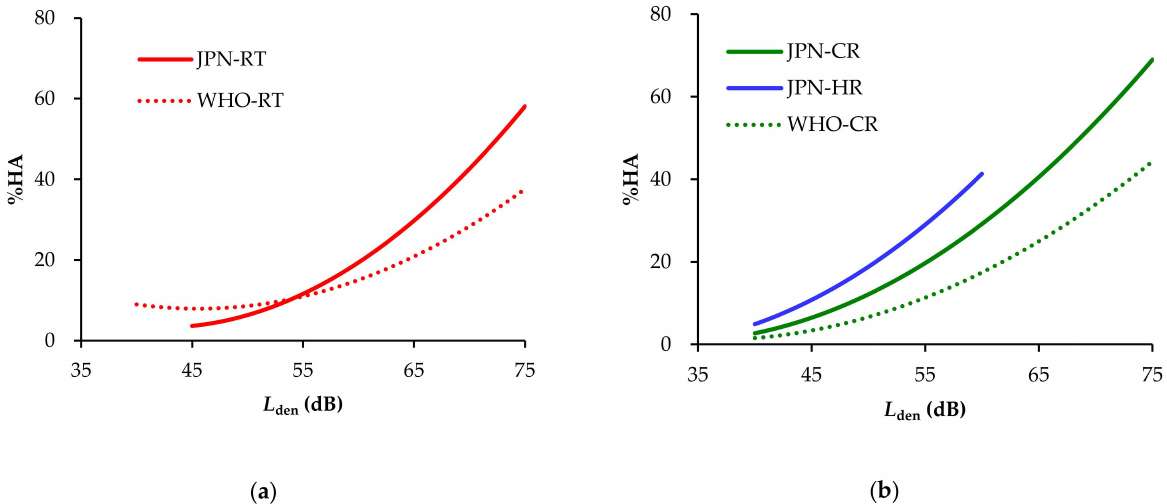
Figure 2. Comparison between estimated exposure–annoyance curves derived from Japanese and WHO datasets: ( a ) Japanese road traffic noise (JPN-RT) vs. WHO road traffic noise; ( b ) Japanese conventional railway noise (JPN-CR) and Shinkansen railway noise of (JPN-HR) vs. WHO railway noise WHO-Rail). Both figures were drawn by interpolating the noise level in 1-dB